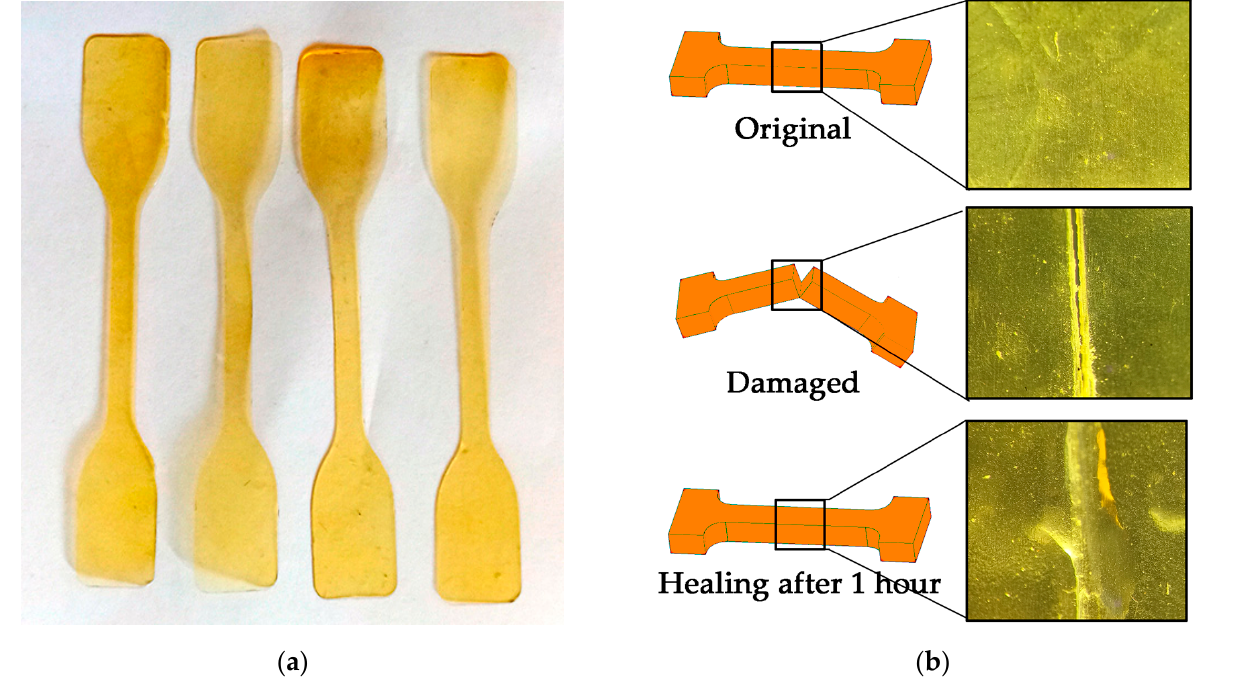
Figure 6. ( a ) Spade specimens for tensile machine studies; ( b ) optical microscopic images of healing of specimens with the addition of 0.1 M HCl to study the physical and mechanical properties.